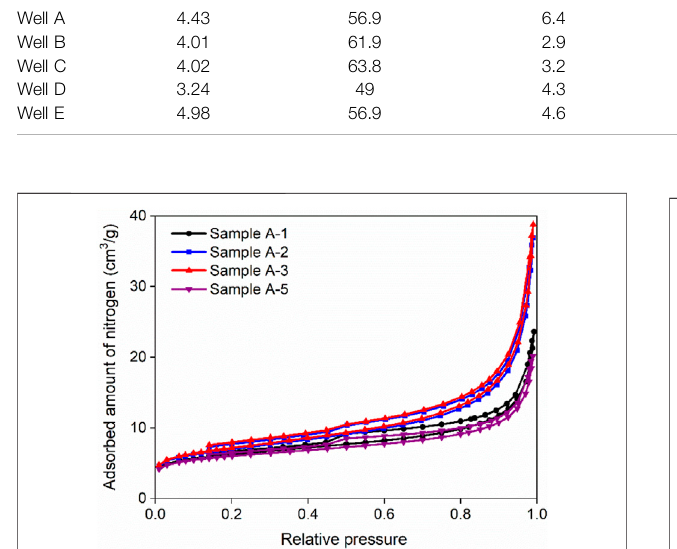
TABLE 1 | Petrological and mineralogical characteristics of Wufeng-Longmaxi Formation in Sichuan Basin. Well TOC (%) Mineral content Quartz (%) Feldspar (%) Carbonate (%) Well A